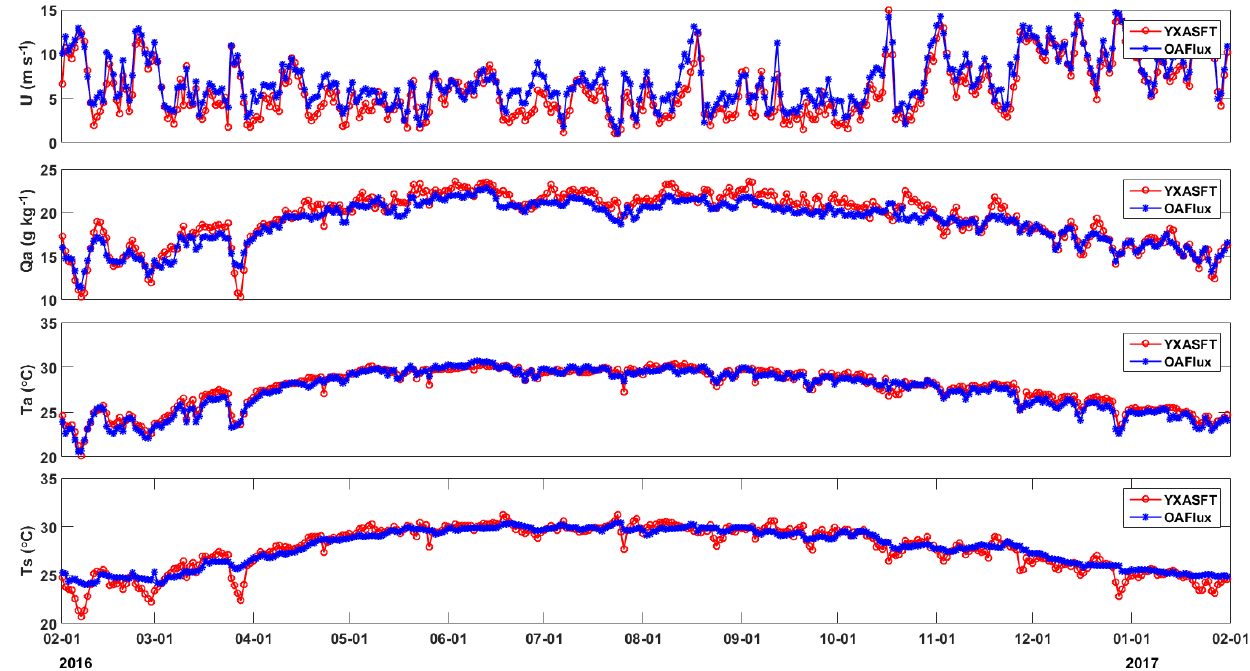
Figure 5. Daily mean time-series plots of the YXASFT-observed (red solid lines) and OAFlux-analyzed (blue solid lines) U , Q a , T a and T s values over the study period (1 February 2016–31 January 2017).